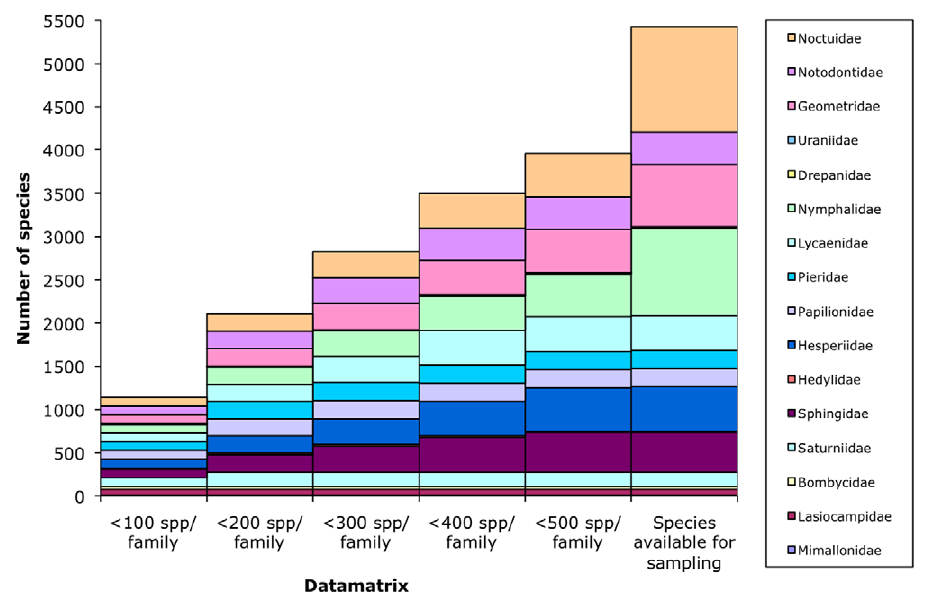
Figure 2. Taxon sampling schemes used to assess the effect of increased taxon sampling on phylogenetic signal in DNA barcode datamatrices. Arctiinae, Lymantrinae and Riodininae species were not included in the sample given current uncertainty over their family level status [28], [52–53]. See also Table S2.